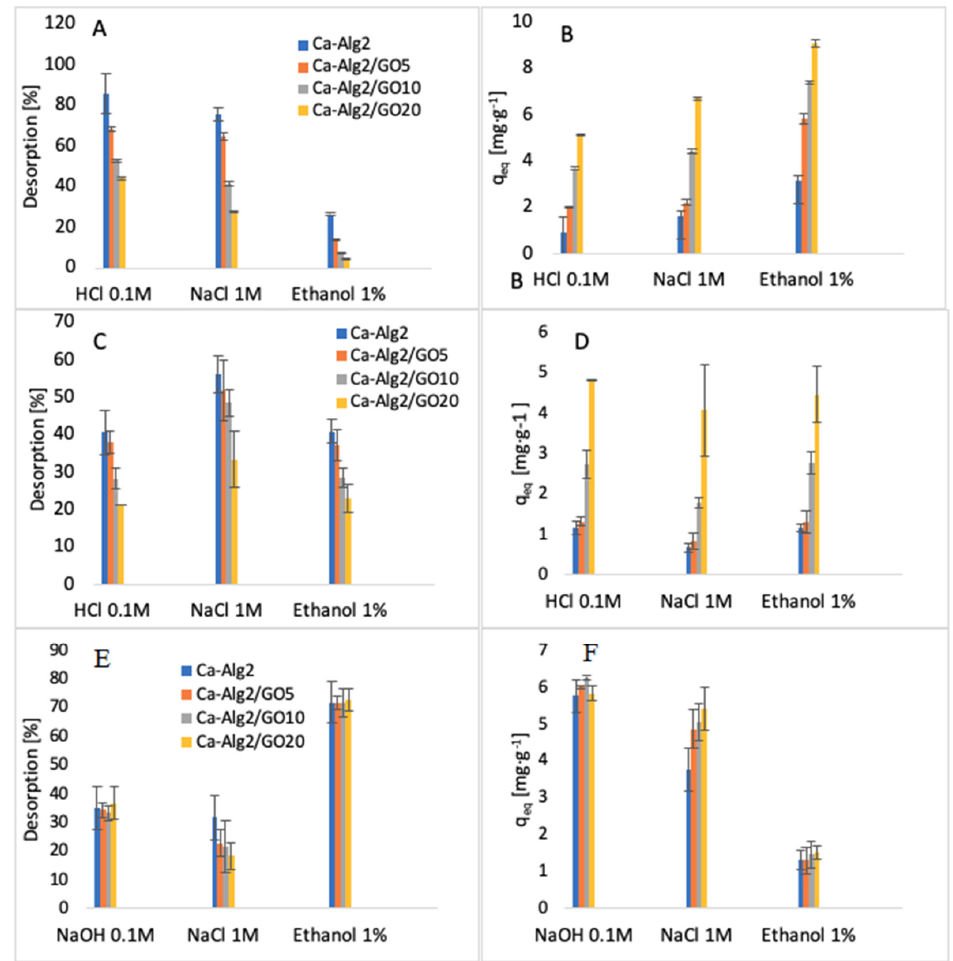
Figure 16. Desorption (%) of MB ( A ), desorption q eq of MB ( B ), desorption (%) of FMTD ( C ), desorption q eq of FMTD ( D ), desorption (%) of DFC ( E ) and desorption q eq of DFC ( F